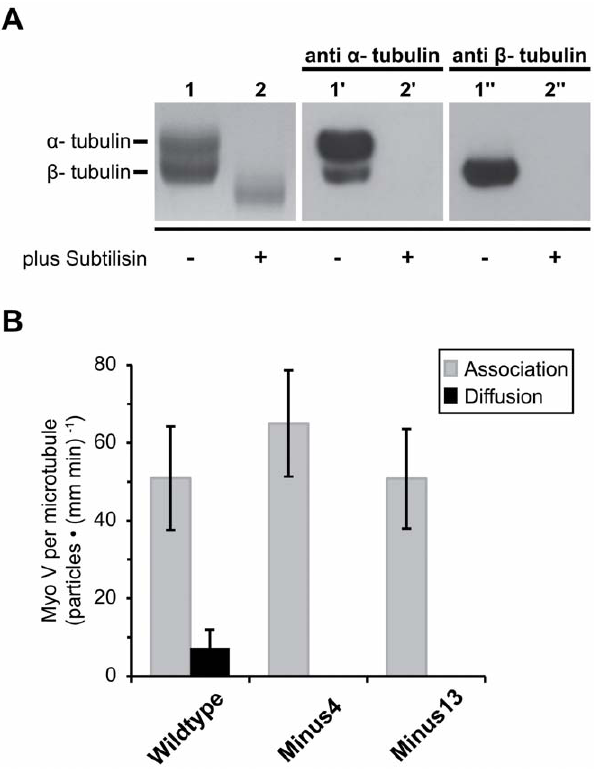
Figure 4. Interaction of myosin V with S-microtubules. (A) Removal of the Carboxy-terminal E-hook from microtubules. (Left panel) SDS/12% PAGE gel of untreated microtubules (lane 1), and after subtilisin-treatment (lane 2). (Middle and right panel) Western blots of these two lanes with anti- a or anti- b tubulin antibodies. Subtilisin- treatment resulted in the complete loss of epitope reactivity, hence complete E-hook removal can be assumed. (B) TIRFM movie sequences of single-molecule experiments with 100 nM Cy3-labeled myo V Wildtype , Minus4 and Minus13 on Atto488-labeled S-microtubules, in 25 mM KCl were analyzed for microtubule-association and subsequent diffusion over a 70-seconds time period. The total number of S- microtubule-associated and diffusing myo V particles per unit length of the microtubules and time of measurement is plotted as category plot for the respective myo V constructs. Error bars represent mean 6 confidence interval ( a =0.95).